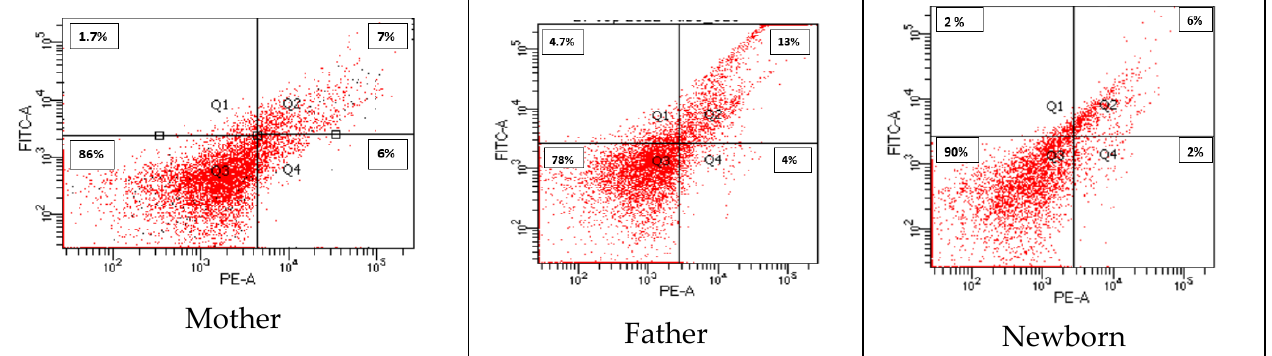
Figure 7. Comparison of immune markers (CD57, KLRG1) among mother, father, and newborn.